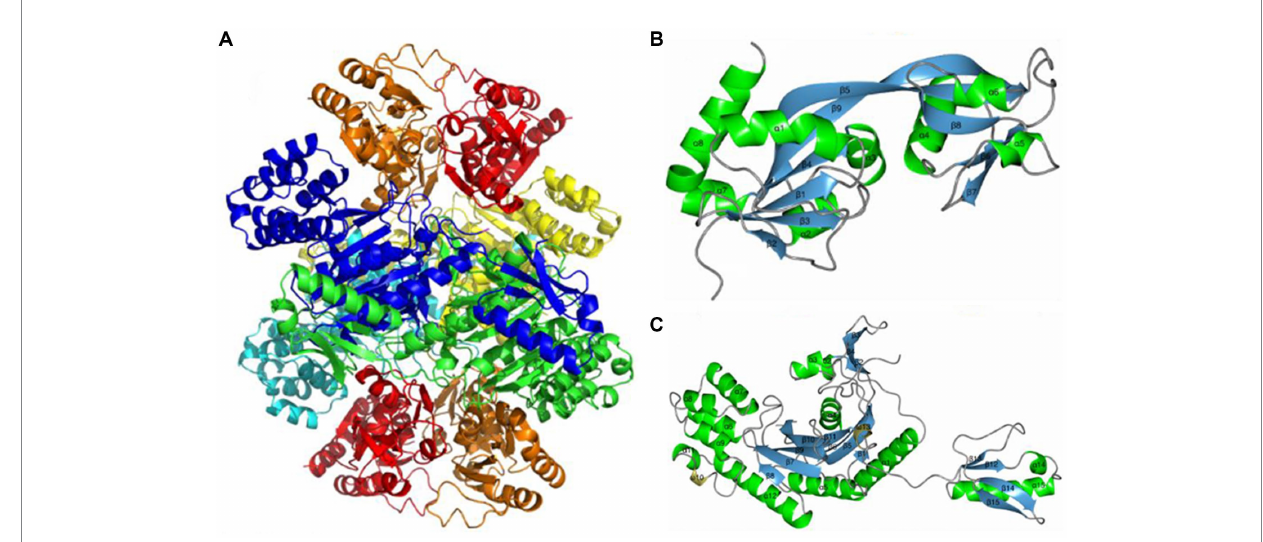
FIGURE 6 ATP phosphoribosyl transferase from Psychrobacter arcticus structure. (A) HisGS and HisZ heterooctamer structure; (B) HisGS monomer structure; (C) HisZ monomer structure (Stroek et al.,